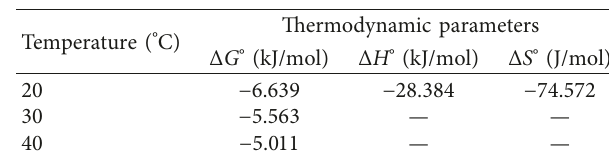
Table 3: Thermodynamic parameters for adsorption of Cr(VI) onto